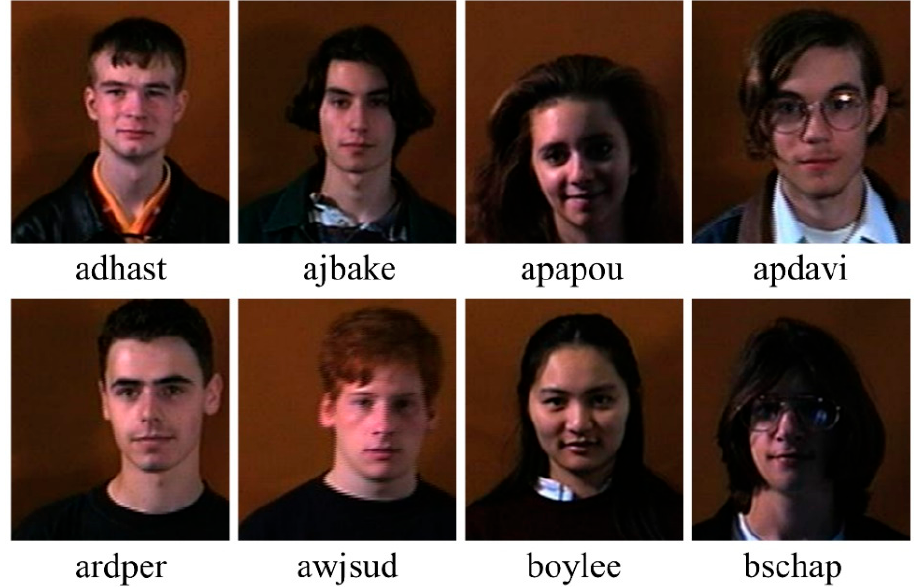
Figure 25. Sample images from the first eight classes of Faces95 database.